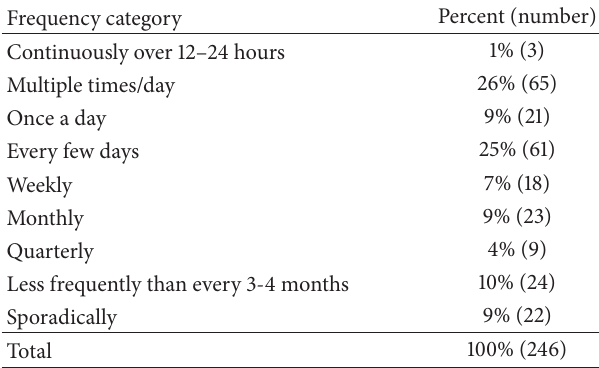
Table 4: Frequency of occurrence of head